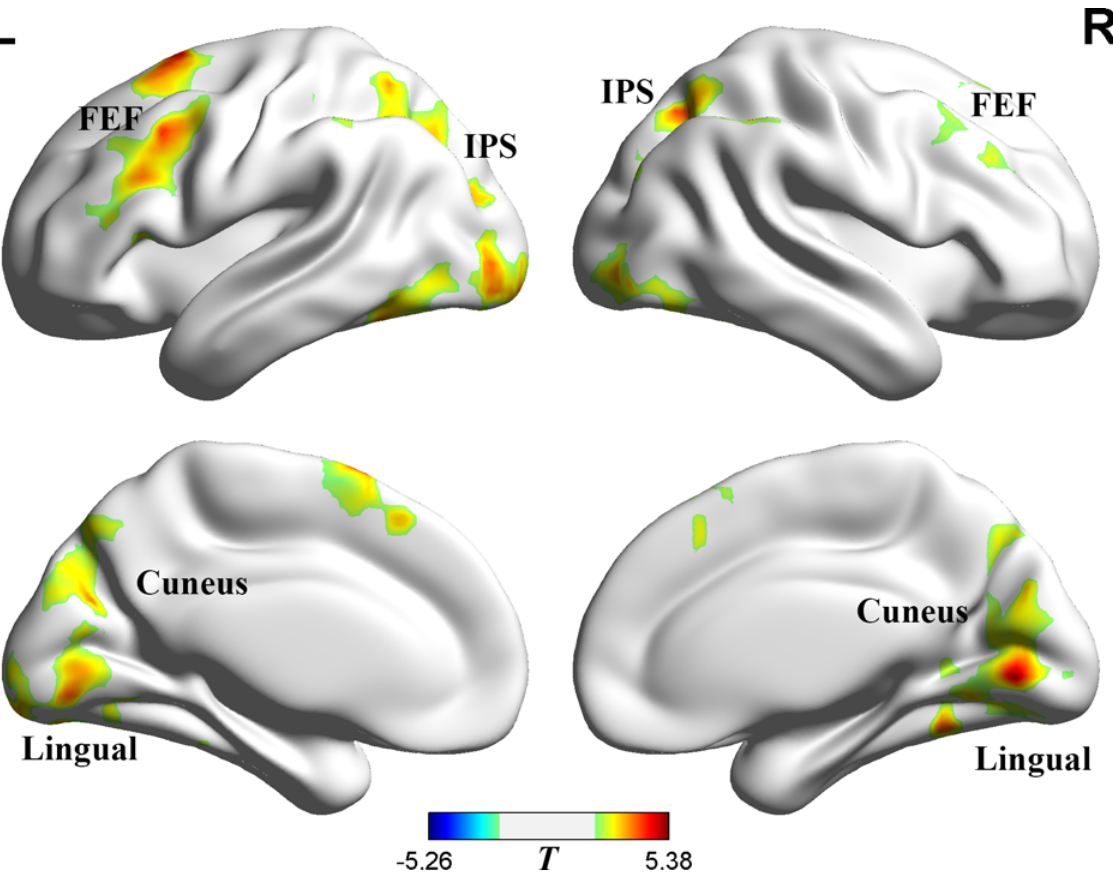
Fig 3. Target-switching condition > distractor-switching condition. Posed on medium view. Threshold: p = 0.05 (AlphaSim corrected). The red shows the regions that are more active in the target-switching